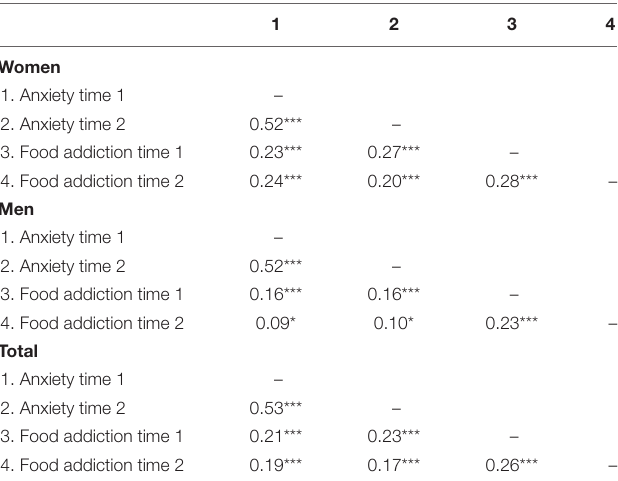
TABLE 2 | Correlations of key variables for women and